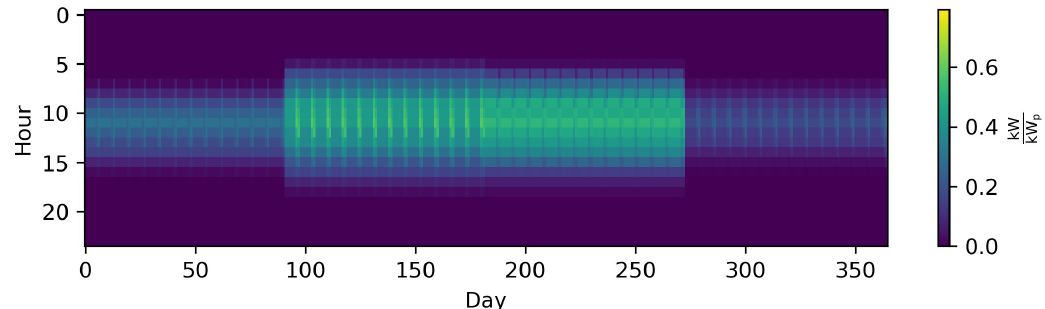
Figure 8. The time series of photovoltaic capacity factors represented by twelve time slices (TSs) (average Wednesday, Saturday and Sunday for each season) as used by Nicolosi et al. and Haydt et al. [104,105] (i.e., 288 different time steps).